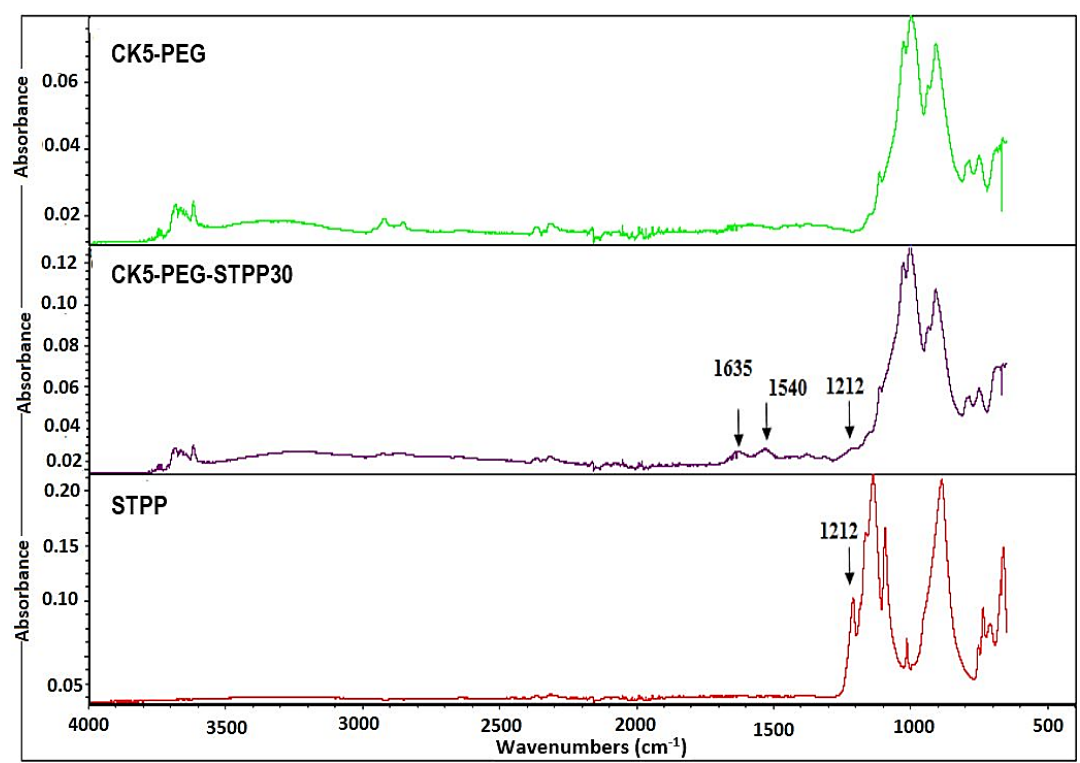
Figure 6. Comparison of ATR-FTIR spectra of CK5-PEG and CK5-PEG-STPP30 composite membranes and STPP powder.